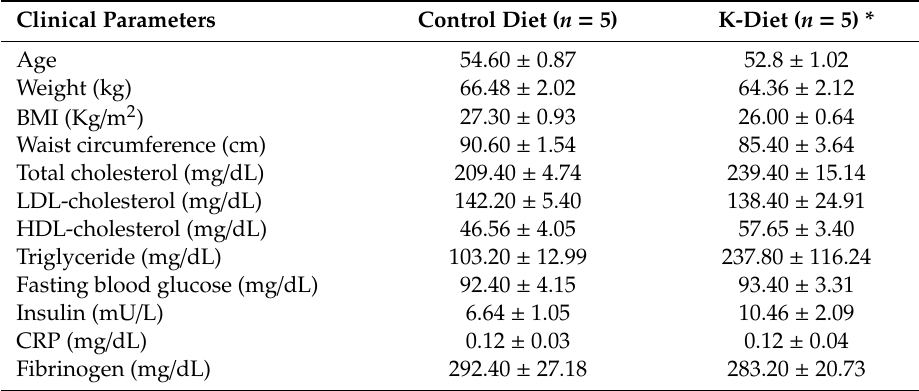
Table 2. Subject profiles.